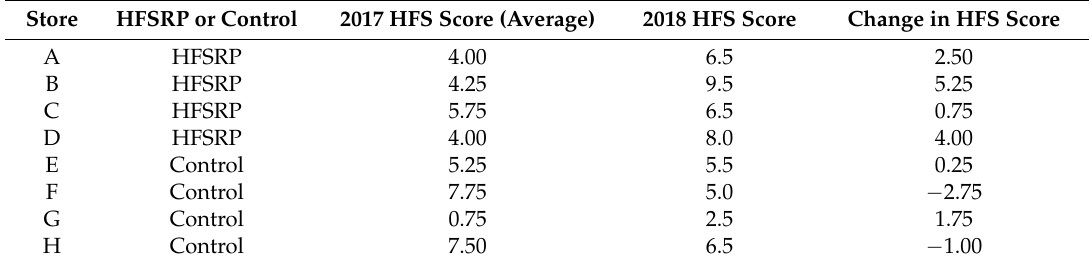
Table 4. Healthy Food Supply (HFS) scores in 2017 and 2018 in four HFSRP stores and four control